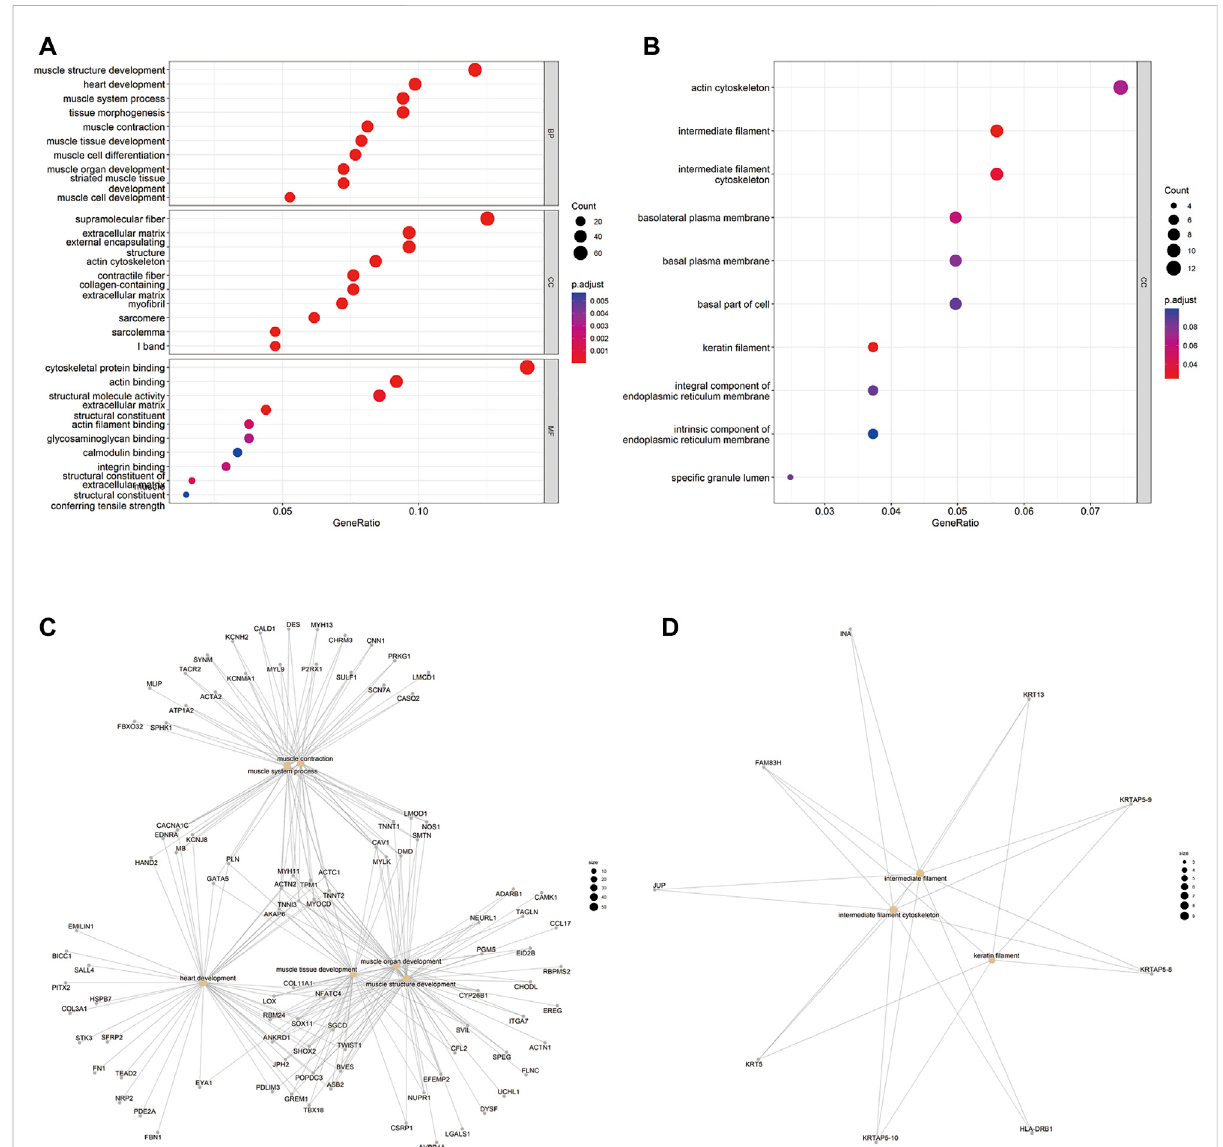
FIGURE 2 GO term enrichment analysis results of DEGs of 5 recurrent vs. 5 primary tumors. (A) GO term function prediction showing the gene ontology enrichment of DEGs up-regulated in recurrent tumors. The ordinate represents GO term description information, BP: biological process, CC: cell composition,MF:molecularfunction, theabscissaisthenumberofdifferentialgenesenrichedto theterm, p < 0.05. The colorofthe p -valueranges from blue (0.005) to red (0.001). (B) GO term function prediction showing the gene ontology enrichment of DEGs downregulated in recurrent tumors. The ordinate representsGO termdescriptioninformation, CC:cell composition,theabscissa isthenumberofdifferentialgenesenrichedto the term, p < 0.05. The color of the p -value ranges from blue (0.06) to red (0.04). (C , D) Cneplot showing the genes involved in the top 9 GO terms enrichment results of the DEGs (left, up-regulated in recurrent tumors; right, downregulated in recurrent